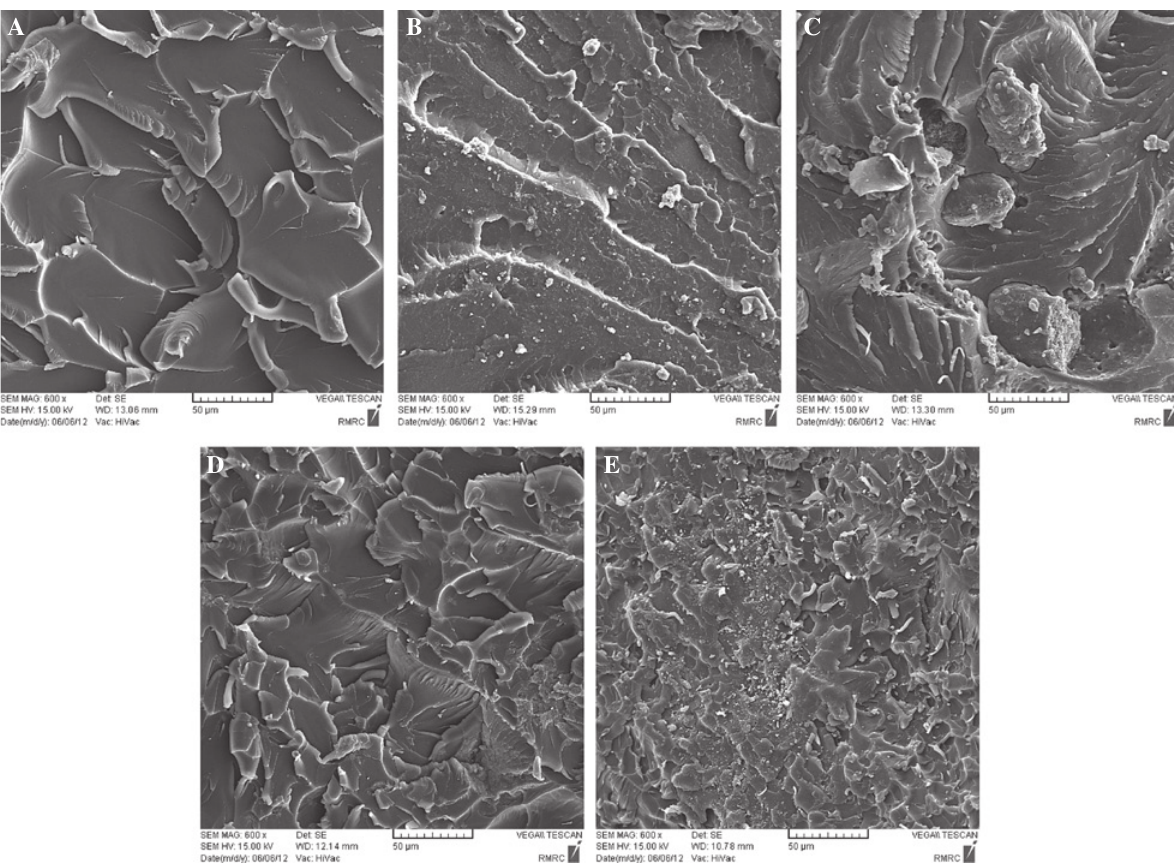
, (C) 4 w% HIPS, (D) 1.5 w% 2